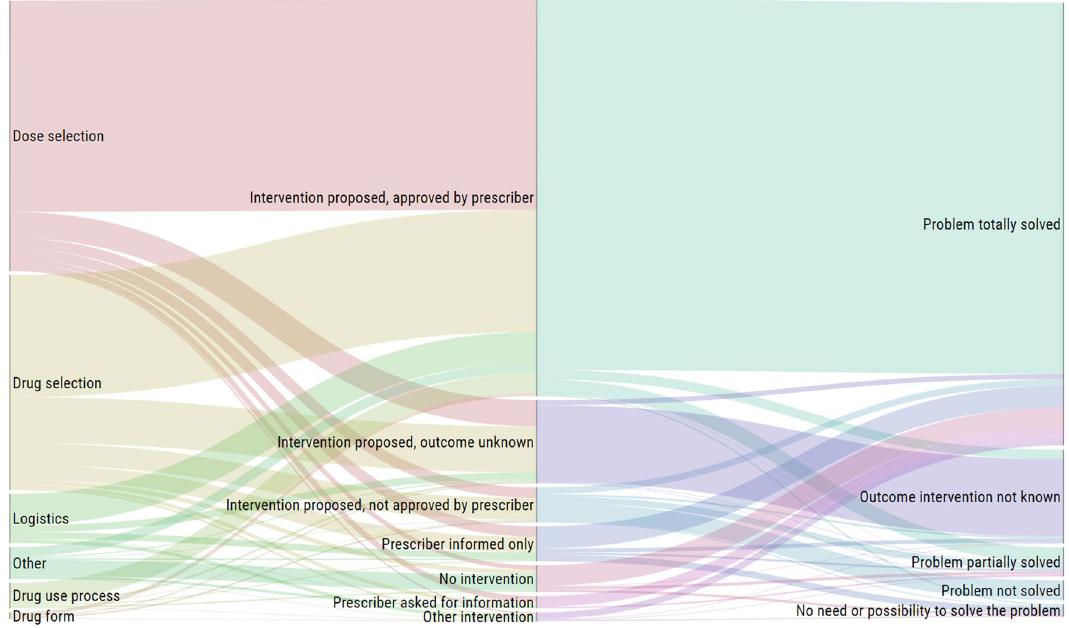
Figure 3. Interventions on DRP pathway. Alluvial diagram representing the flow and correlation throughout the dimensions “cause, intervention at prescriber level, and outcome” of DRPs. Height size is proportional to the number of DRP in each